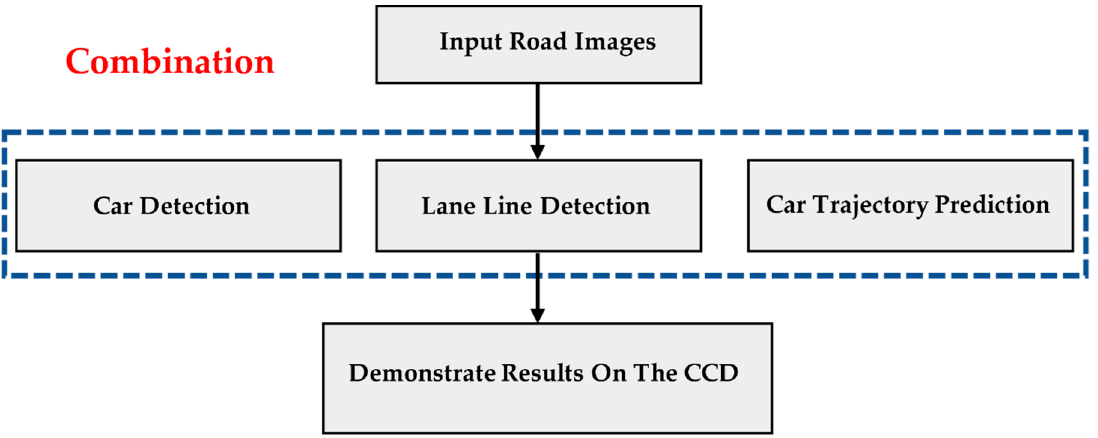
Figure 19. Combination of three techniques